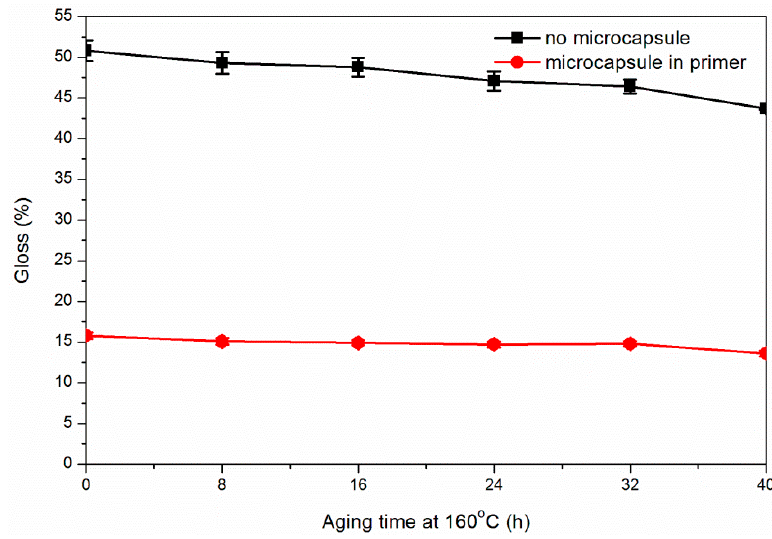
Figure 9. Effect of aging time on gloss of paint film in the 120 °C oven.